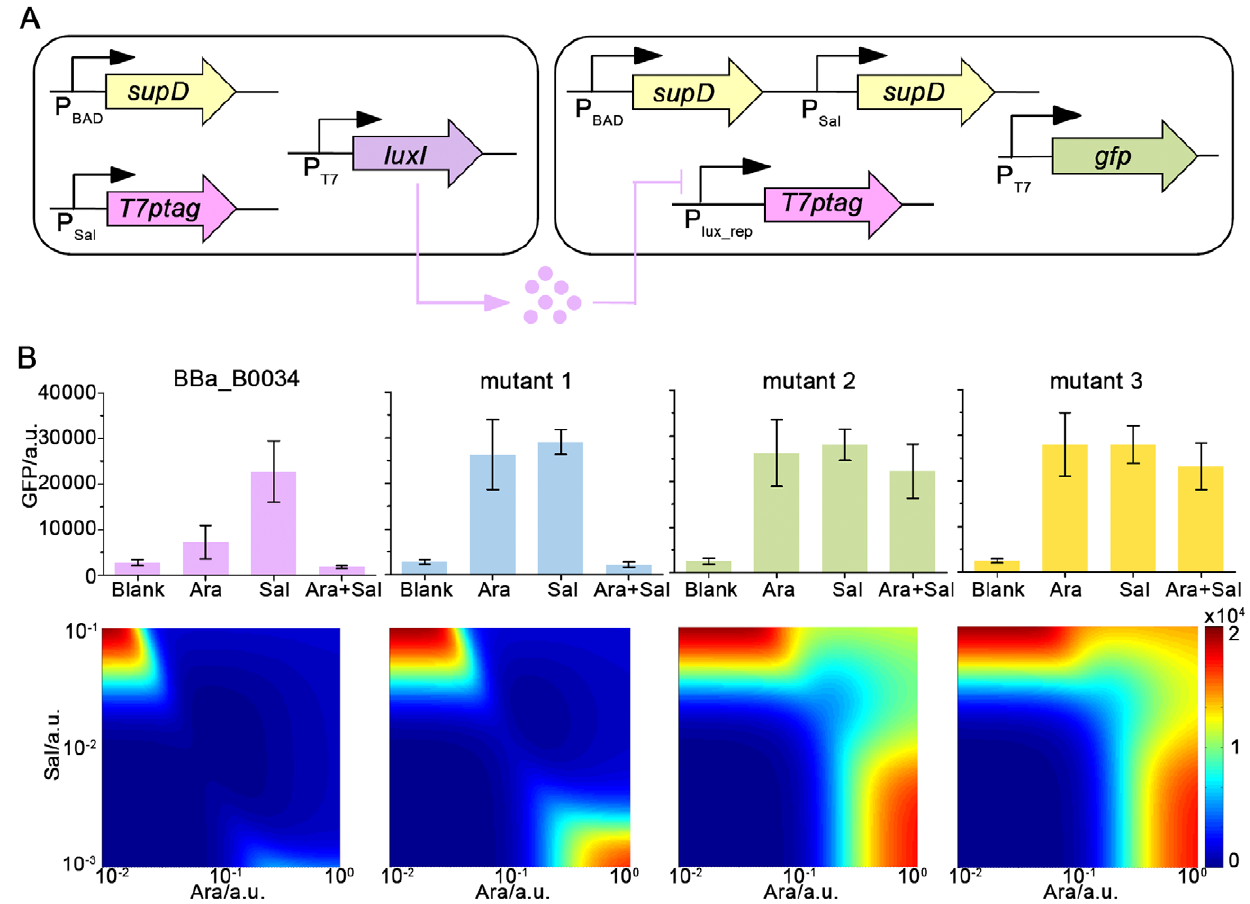
Figure 3. Fine-tuning of circuiting interface between USC and DSC. (A). Schematics of XOR-function gene circuit encoded within the entire microbial consortium. LuxI, a synthase of AHL, works as output of USC. AHL transduces a repressive signal to DSC. (B). Upper panels: experimental results using diluted filtrate from induced USC. Four histograms represent results for 4 different RBS sequences: AAAGAGGAGAAA (BBa_B0034), ATTAAAGTTGAGAAA (Mutant 1), GCTCCATCCCCG (Mutant 2), and GCTCCTCCGATC (Mutant 3), with RBS strength 9-, 108- and 150-fold attenuated, respectively, predicted by RBS Calculator. In each histogram, corresponding inputs are: (left to right) no inducers (blank), arabinose only (Ara), salicylate only (Sal), and both inducers (Ara + Sal). Error bars are calculated as mean 6 s. d. Lower panels: phase diagrams of the entire circuit predicted by model using characterization data for individual logic operating cells.